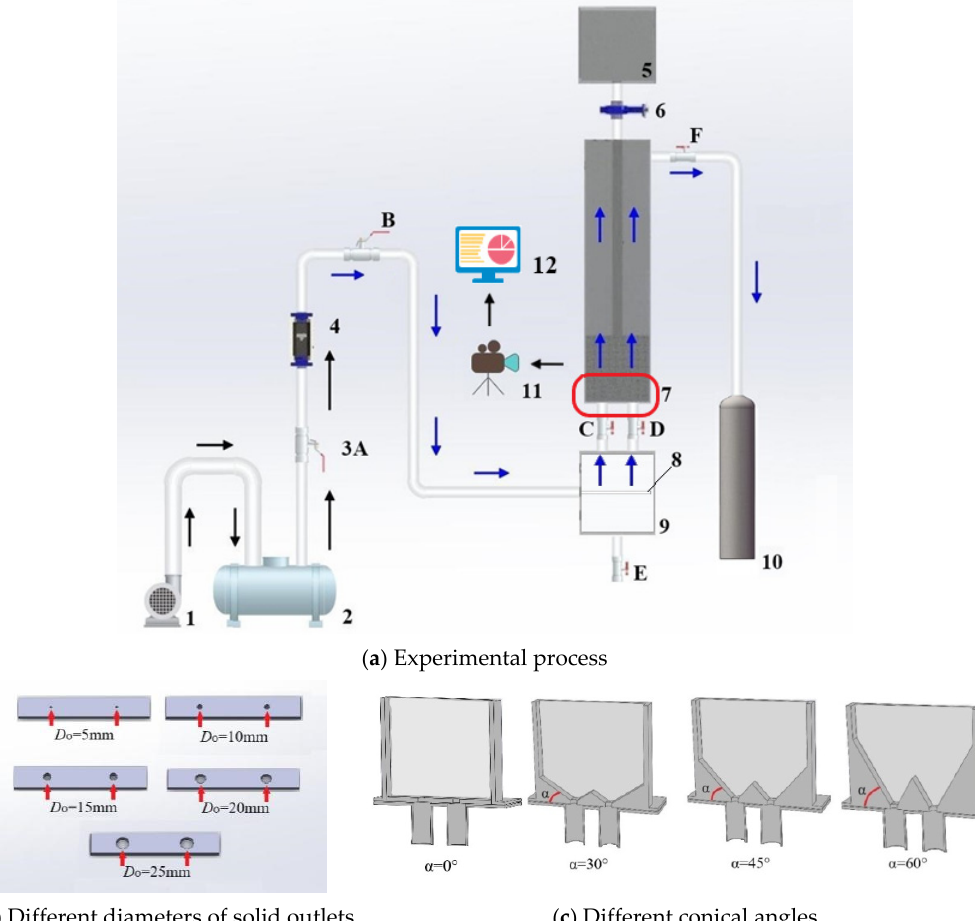
Figure 1. Schematic diagram of experimental process and device. (( b , c ) correspond to the zone marked in red in ( a ), where the bed has a width equal to 240 mm). 1—blower; 2—buffer tank; 3—ball valves (A, B, C, D, E, F); 4—rotameter; 5—top silo; 6—butterfly valve; 7—moving bed; 8—gas distributor; 9—bottom silo; 10—bag filter; 11—camera.